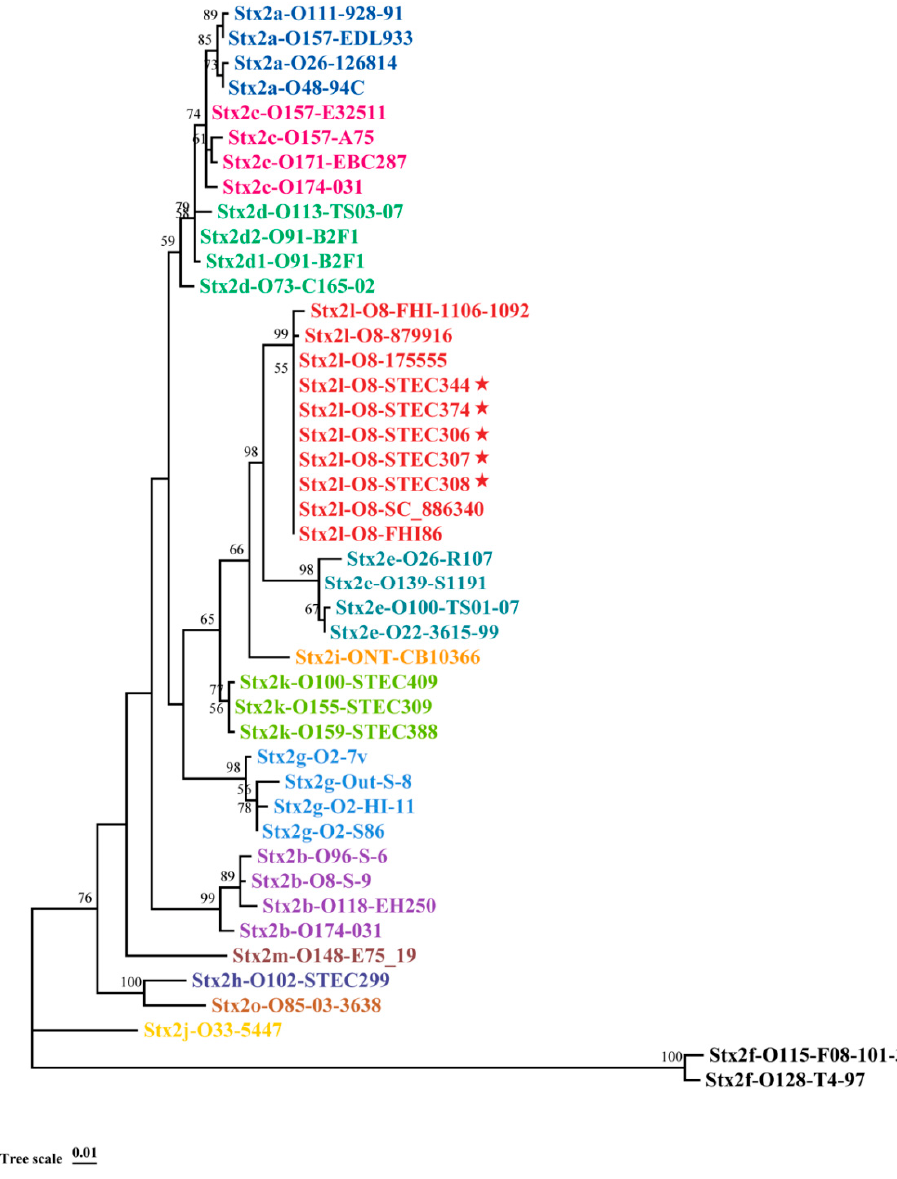
Figure 1. Phylogenetic tree of the Stx2 subtypes by the Neighbor ‐ Joining method. The Neighbor ‐ Joining tree was inferred from comparison of the combined A and B holotoxin amino acid sequences of all Stx2 subtypes. The numbers on the tree indicate the bootstrap values calculated for 1000 subsets for branch points > 50%. Tree scale, 0.01 substitutions per site. Stx2 subtypes are indicated by different colors. The red stars indicate strains in this study.